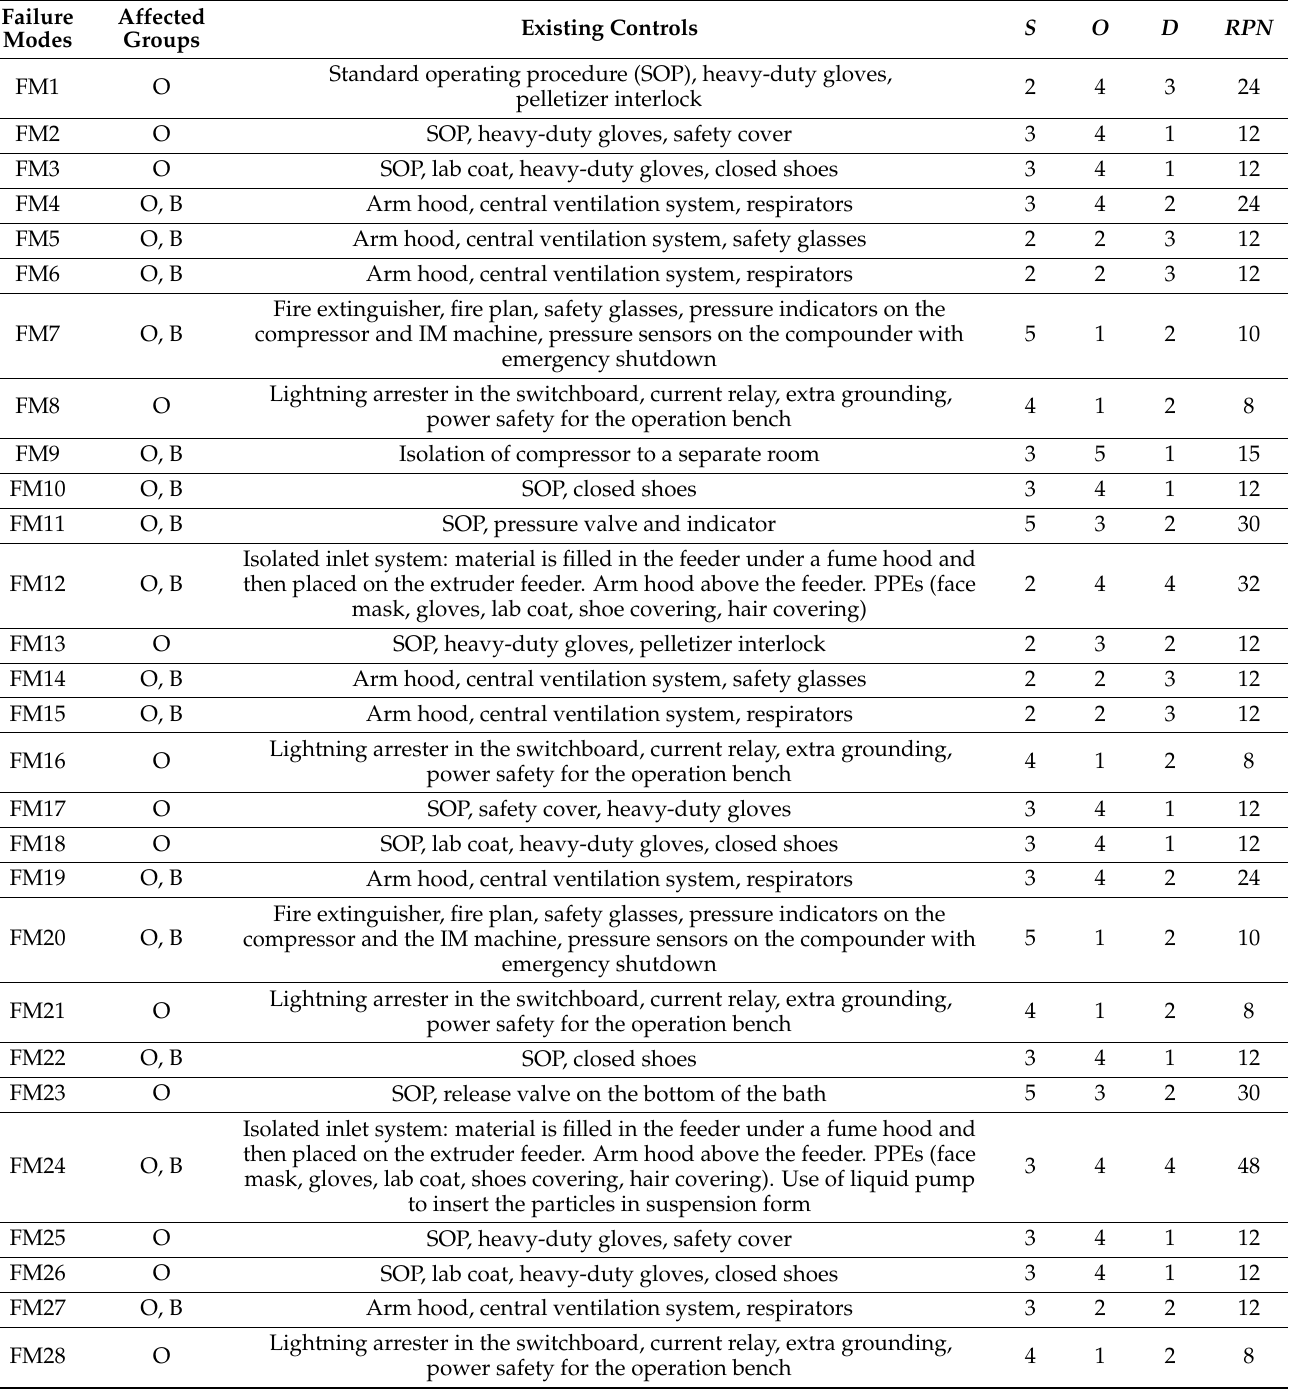
Table 3. Failure mode and effect analysis (FMEA) of the repurposed injection moulding